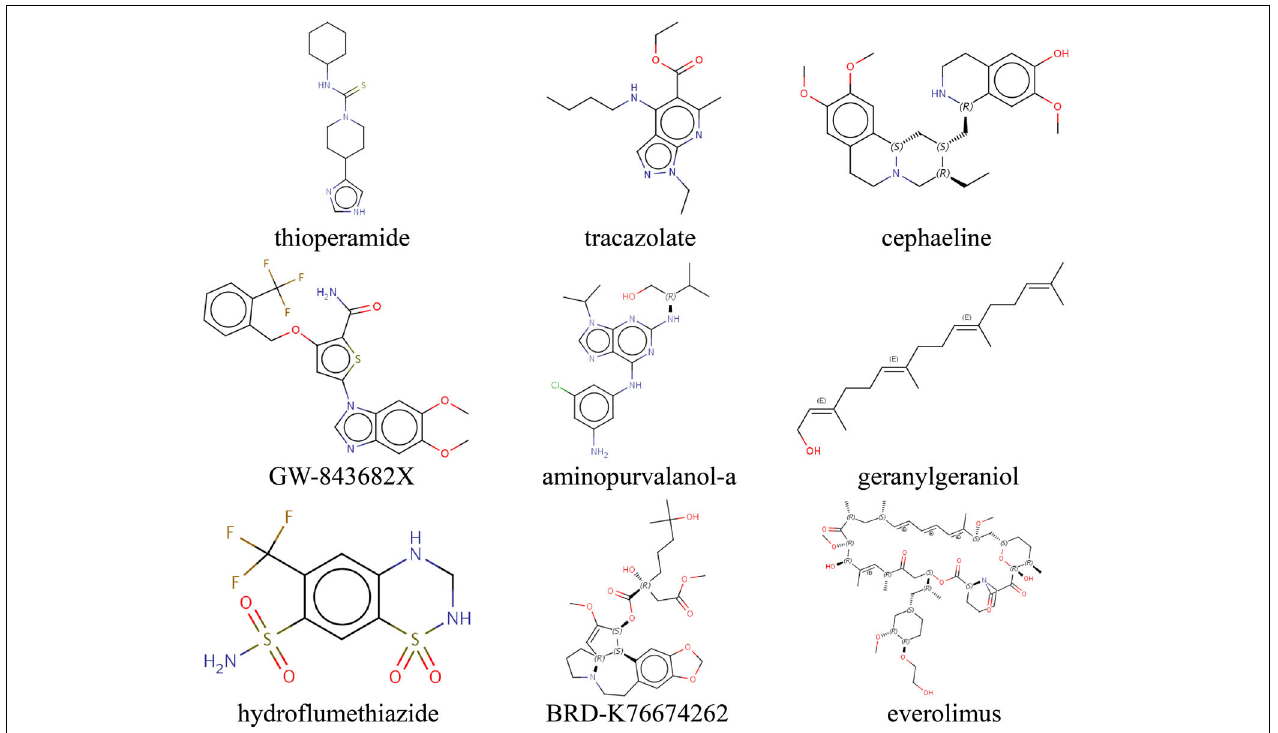
FIGURE 9 | Identifying the molecular structure of 9 small component drugs targeting ERS-related gens in IAs by